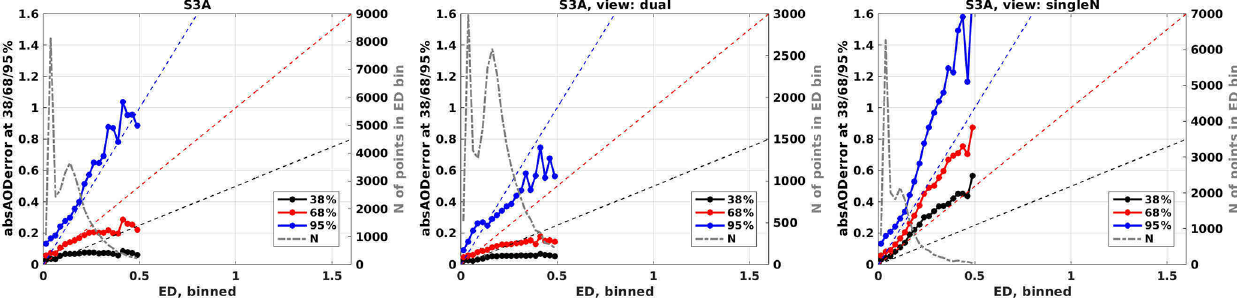
Figure 17. Percentile plots of absolute AOD errors at 38% (black), 68% (red), and 95% (blue) as a function of binned expected discrepancy. Table 2. For S3A and S3B, annual (for the globe, NH, and SH) and seasonal (for the globe) validation statistics for syFMAOD. Period